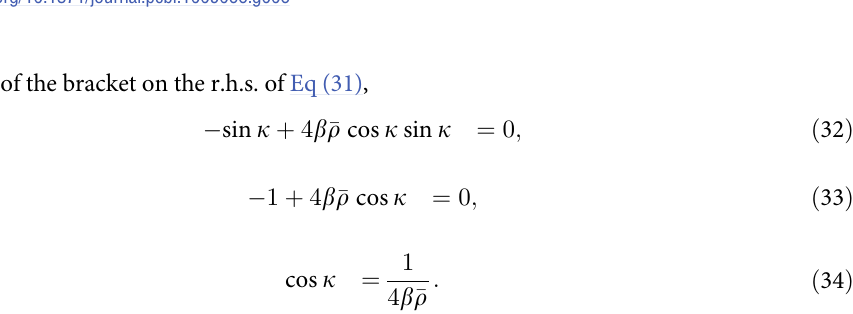
Fig 6. Pattern formation in the LGCA aggregation model. Left: critical wave length obtained from the mean-field analysis. The critical wave length diverges for ð b � r Þ ! ð b � r Þ periodic pattern from a homogeneous initial state. The horizontal distance of the orange dashed lines is equal to the critical wave length predicted by mean-field analysis. Parameters: b ¼ 100 ; � r ¼ 1 ; a ¼ 2